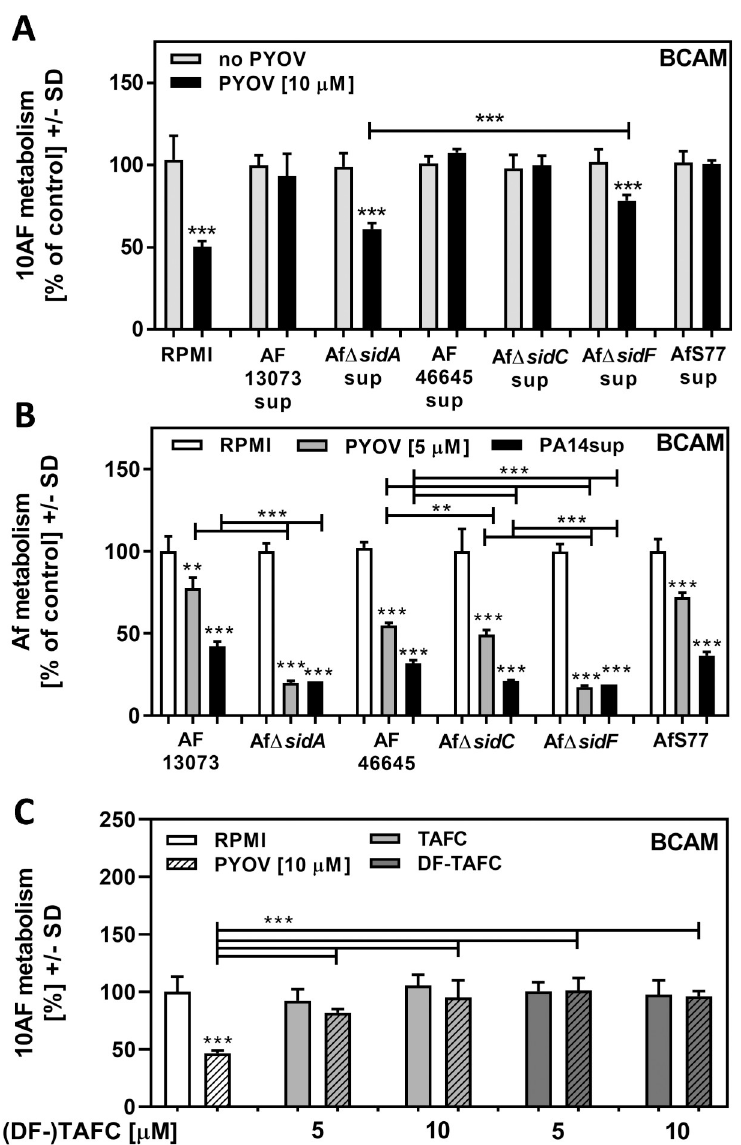
Fig 4. Af Δ sidA is more sensitive towards PA14 or pure pyoverdine than its wildtype. A: Mixtures (25%) of freshly prepared AF13073, Af Δ sidA , AF46645, Af Δ sidC , Af Δ sidF , or AfS77 supernatants were combined with pyoverdine [10 μ M], and tested for effects on 10AF forming biofilm metabolism. Fungal metabolism was measured by XTT assay. Measurements for controls (no pyoverdine) in each group were regarded as 100%. Statistics: t-Test, for each group: no pyoverdine (grey bar) vs. pyoverdine (black bar). Other comparison as indicated by the ends of the bracket. B: AF13073, Af Δ sidA , AF46645, Af Δ sidC , Af Δ sidF or AfS77 BCAM assays were incubated with either RPMI, PA14 supernatant, or 5 μ M pyoverdine. Fungal metabolism was measured by XTT assay. For each fungus RPMI control measurements were regarded as 100%. Statistics: t-Test, comparison: RPMI (white bars) vs. PA14 supernatant (grey bars), or pyoverdine (black bars) for each fungus. Other comparisons as indicated by the ends of the brackets. C: A 10AF BCAM assay was incubated with either RPMI, pyoverdine [10 μ M], TAFC [5 or 10 μ M], DF-TAFC [5 or 10 μ M], or combinations of pyoverdine and TAFC or DF-TAFC. Fungal metabolism was measured by XTT assay. RPMI control measurements were regarded as 100%. Statistics: t-Test, comparison: RPMI (white bar) vs. all other bars. Other comparisons as indicated by the ends of the brackets. One, two or three asterisks = p � 0.05, p � 0.01 or p � 0.001, respectively.